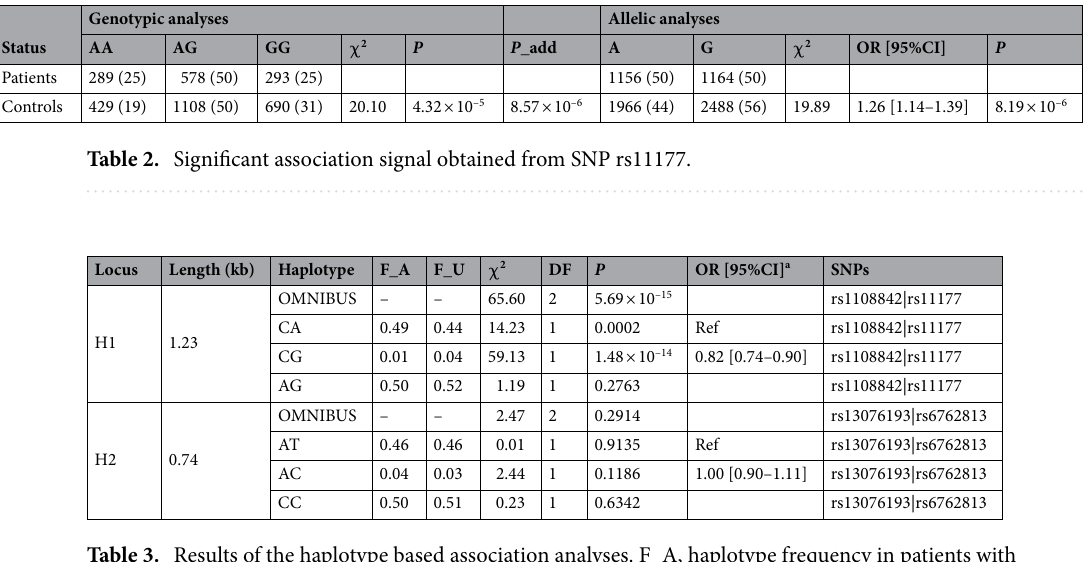
Table 3. Results of the haplotype based association analyses. F_A, haplotype frequency in patients with hand OA; F_U, haplotype frequency in controls; DF, degree of freedom. a For H1, the ORs were calculated for CG + AG versus CA. For H2, the ORs were calculated for AC + CC versus AT.